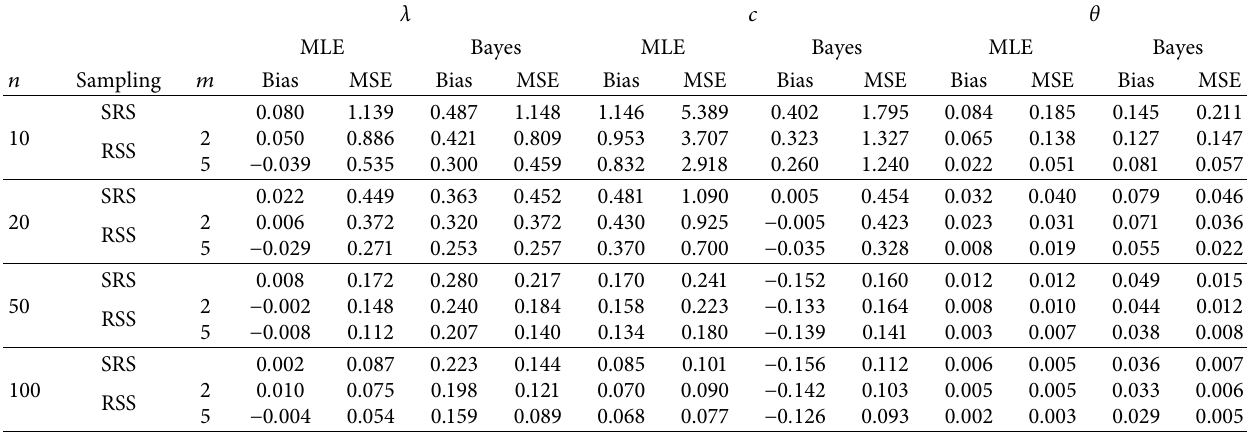
Table 2: Bias and MSE of the MLE and Bayes estimates under RSS and SRS for different sample sizes and different set sizes when λ � 1 . 0, c � 0 . 5, and θ � 0 .